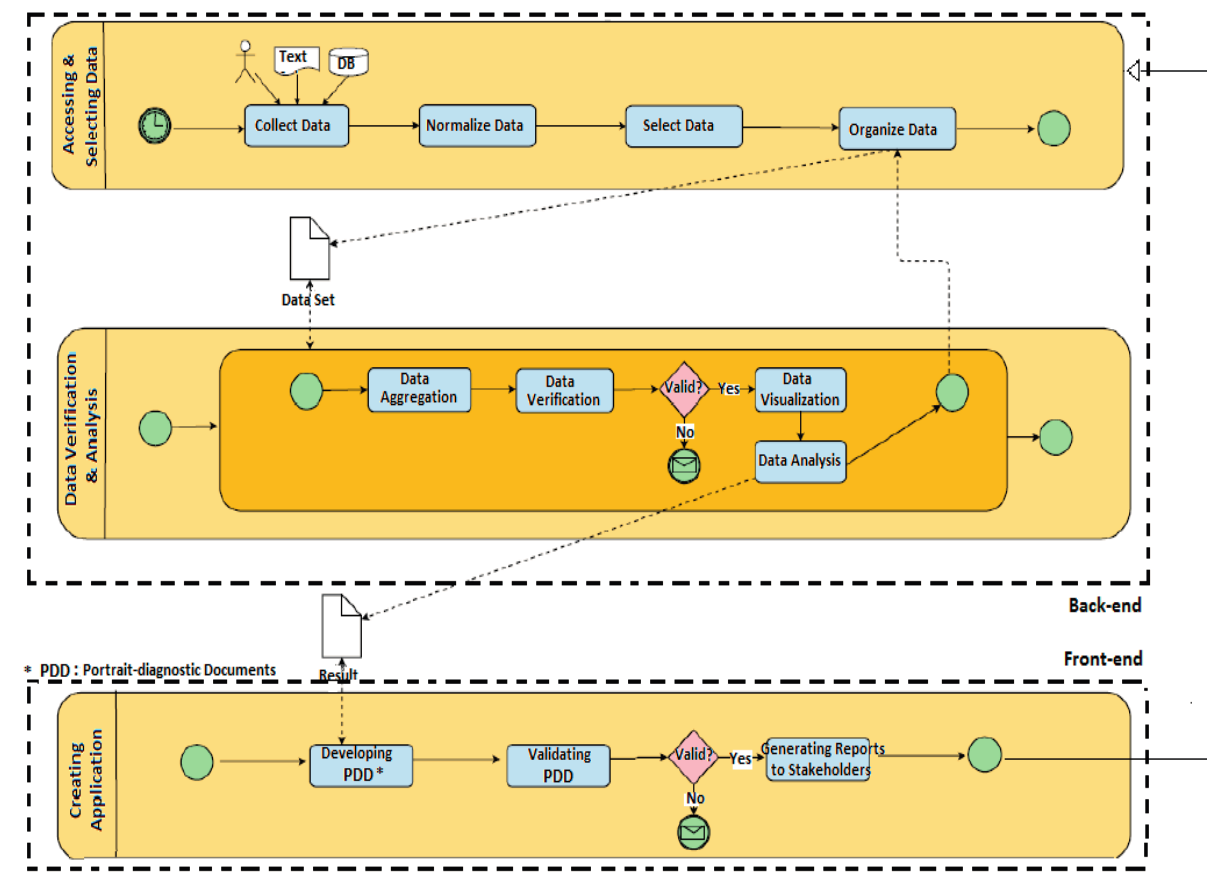
Figure 3. Mapping of observed processes for developing epidemiological